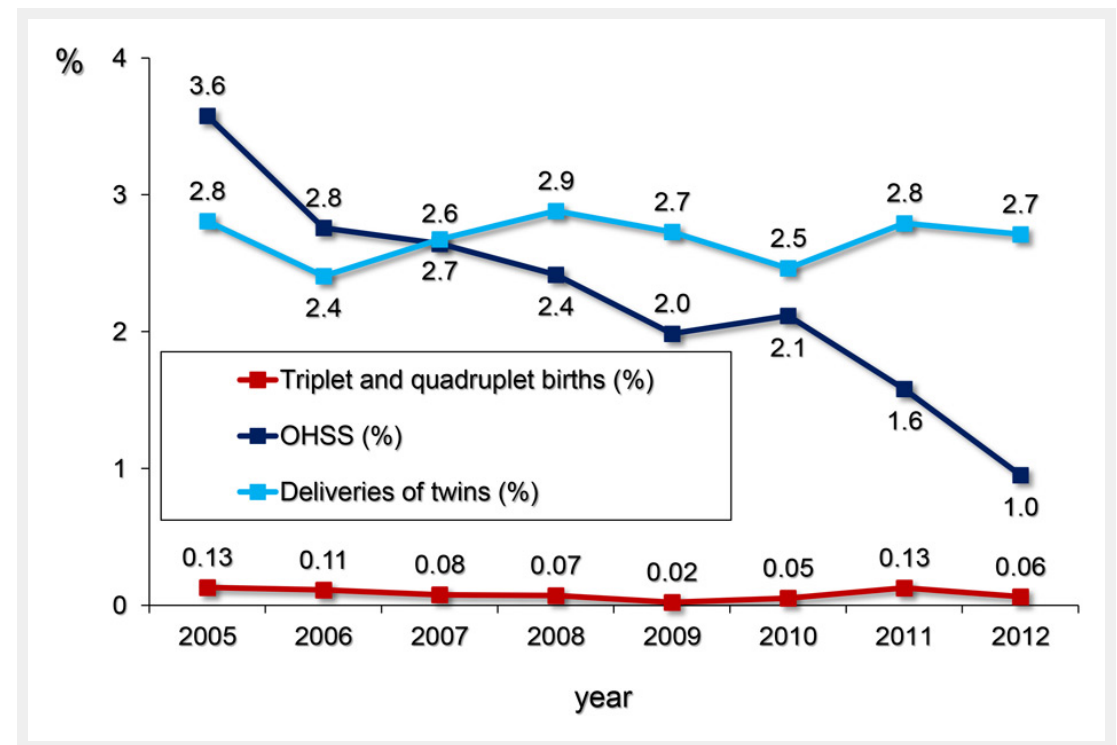
Figure 4 The yearly proportion (%) of twin, triplet and quadruplet deliveries per treatment cycle with ART (including both fresh and thawing cycles) and the proportion of OHSS per freshly stimulated treatment cycles (in %) was calculated from the pooled FIVNAT-CH data collected between 2005 and 2012. While the number of multiple births has remained constant, the incidence of OHSS dropped from 3.6%